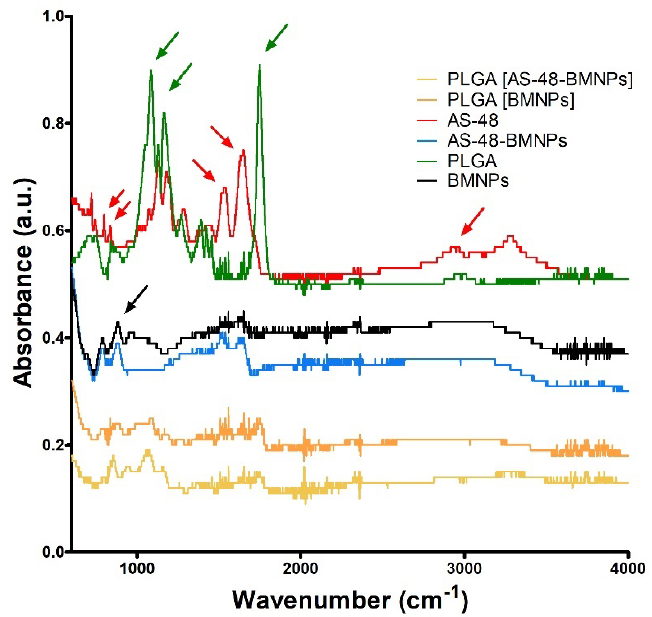
Figure 1. FTIR spectrum collected in the range between 600 and 4000 cm − 1 . The black arrow stands for adsorption bands associated with magnetite (lines in black), AS48 distinctive adsorption bands are marked with red arrows and those for PLGA are marked with green arrows.